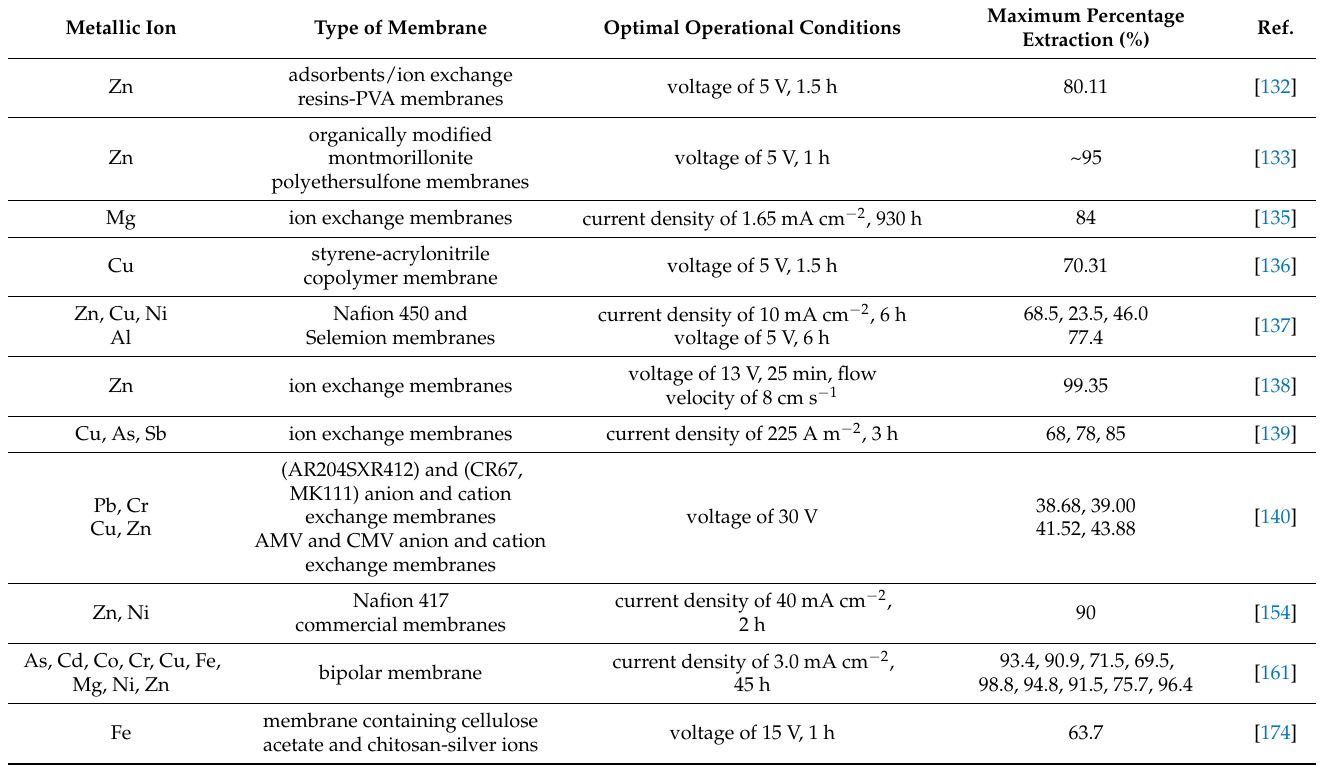
Table 3. The values of extraction percentage of different metallic ions from various wastewaters using